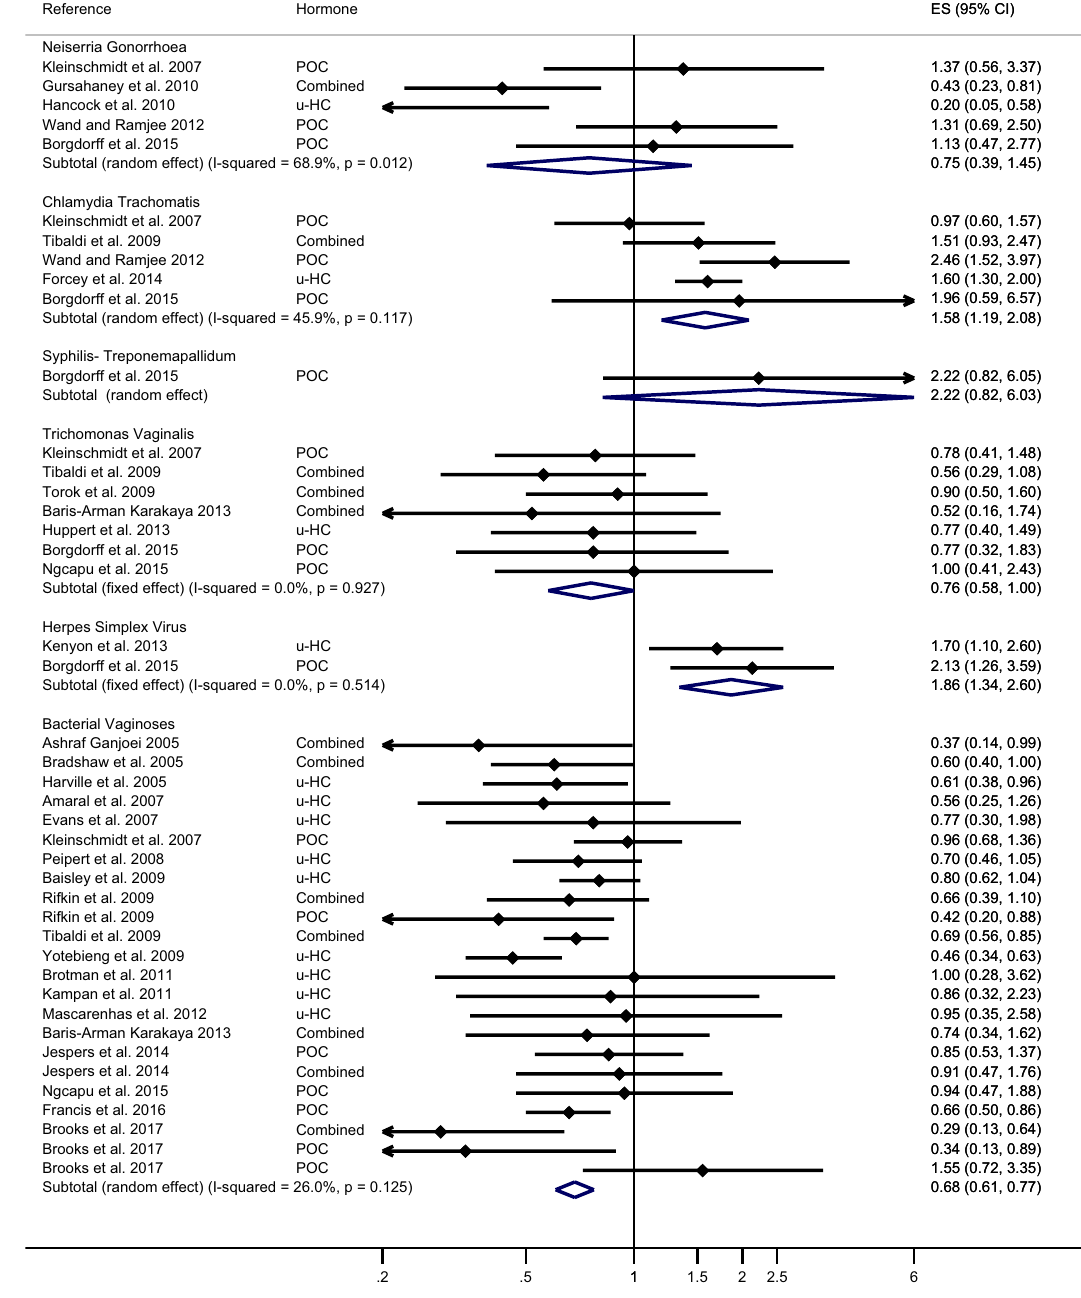
Figure 3. Meta-analysis of the association between hormonal contraceptives and the prevalence of STIs/BV. The diamond in the middle of each horizontal line represents the point estimate of the effect for a single study. Each horizontal lines depict the 95% confidence interval (CI) for a study and the lines that extend beyond the specified value range are cropped and adorned with arrows. The group-specific effect size is plotted by diamond (without horizontal line) with the width corresponding to its 95%